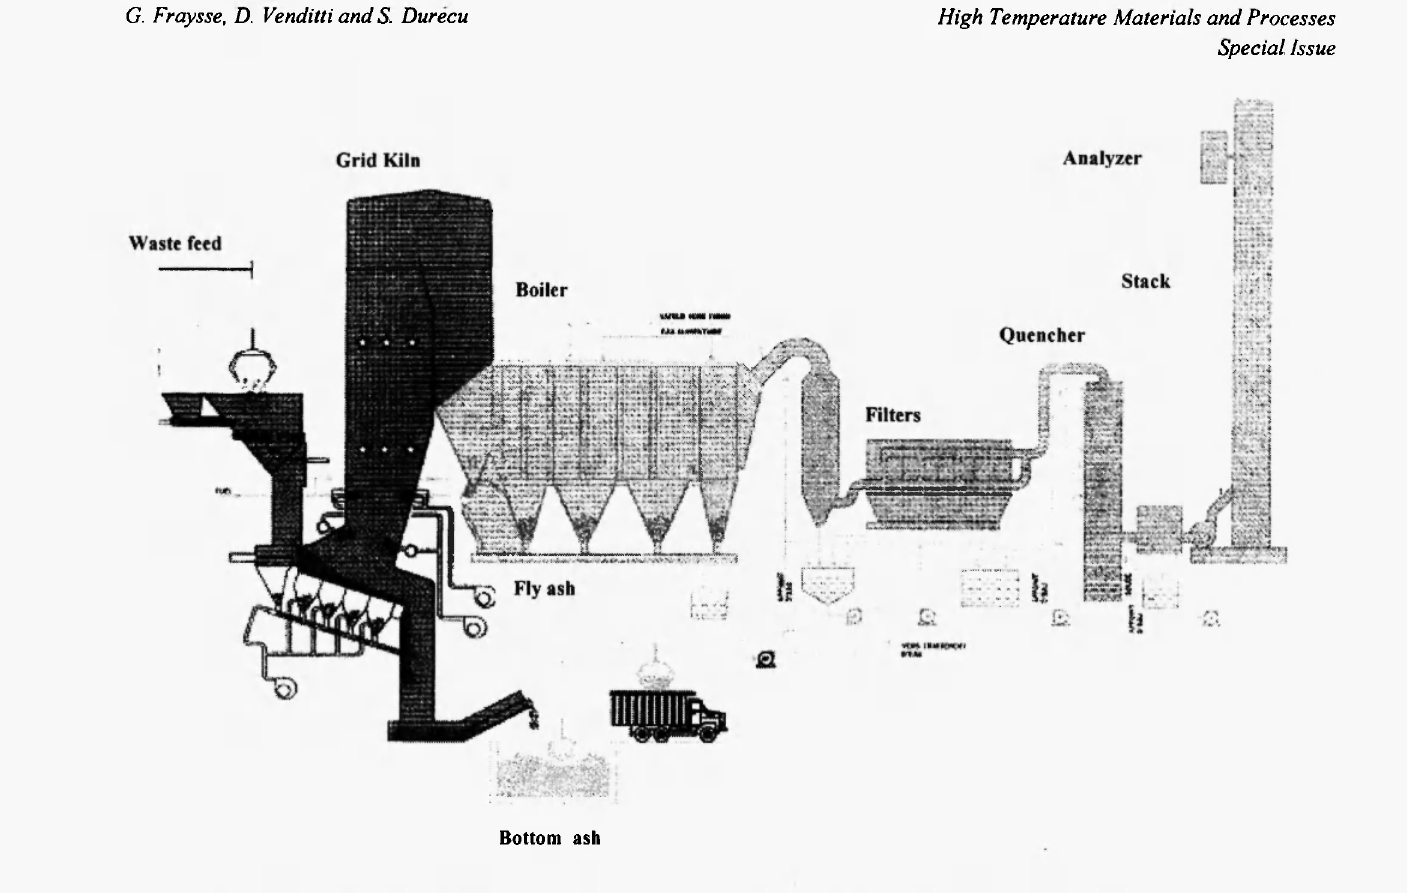
Fig. 1: Flow sheet of TREDI Salaise III Waste Incineration Plaht, Salaise-sur-Sanne, France. Stars ( *) indicate the 6 urea injection points in the posf-combustion zone